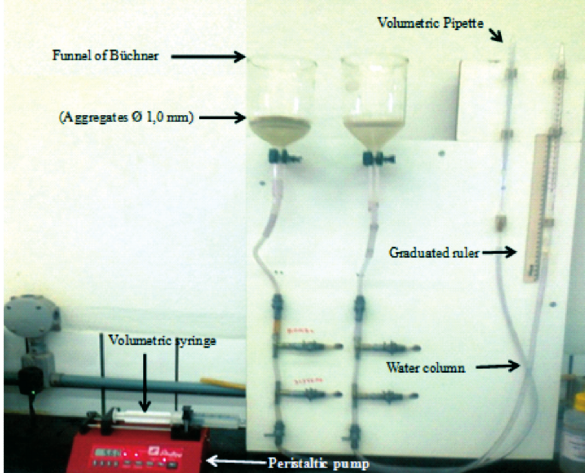
Figure 1. Equipment designed to evaluate the stability of aggregates by the HEMC method, adapted from Avanzi et al. (2011).